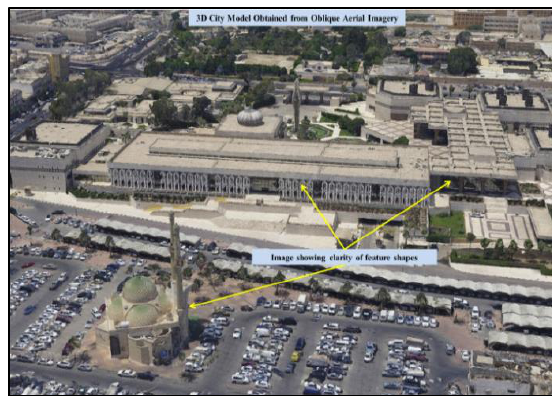
Figure 8. 3D texture obtained from oblique imagery (b). The 3D city model results for aerial imagery delineates poor texture, deformed feature shapes in the output results